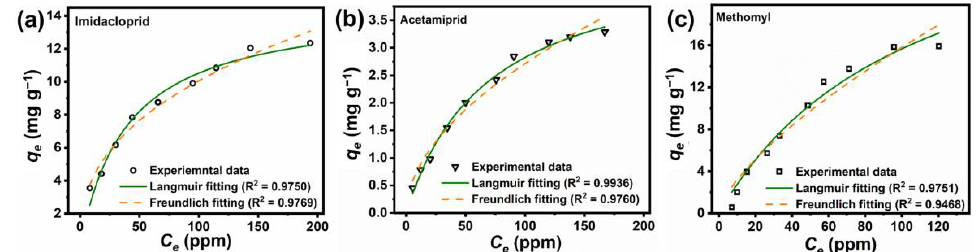
Figure 3. Two-parameter adsorption isotherms of ( a ) imidacloprid, ( b ) acetamiprid and ( c ) methomyl on the BC, respectively, by the Langmuir and Freundlich models. Conditions: 100 mL of aqueous solution of pesticide; initial concentrations = 10–200 ppm, pH = 7, 25 °C, 6 h.